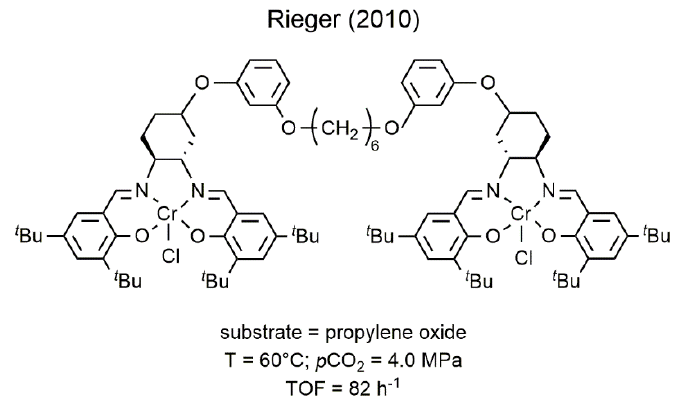
Figure 6. Bimetallic chromium(III) Salen complex developed by Rieger for the coupling of CO 2 with PO [56].